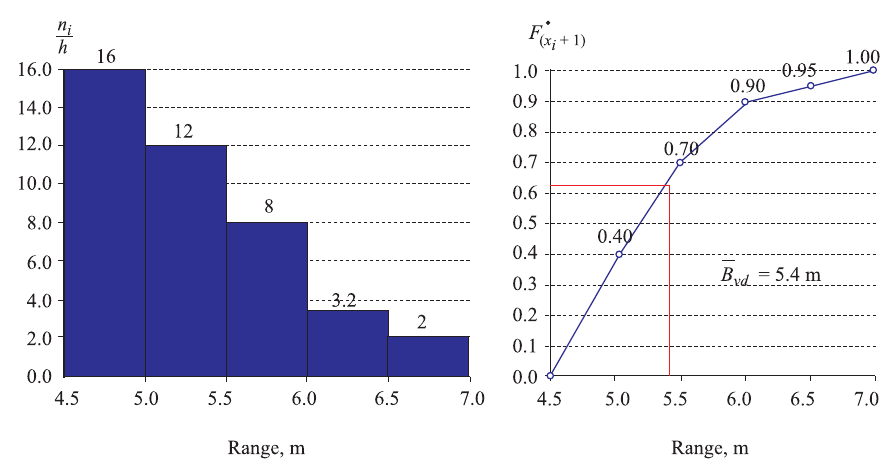
Fig. 6. Absolute frequency histogram and empirical distribution function of the variation in the carriageway width of small